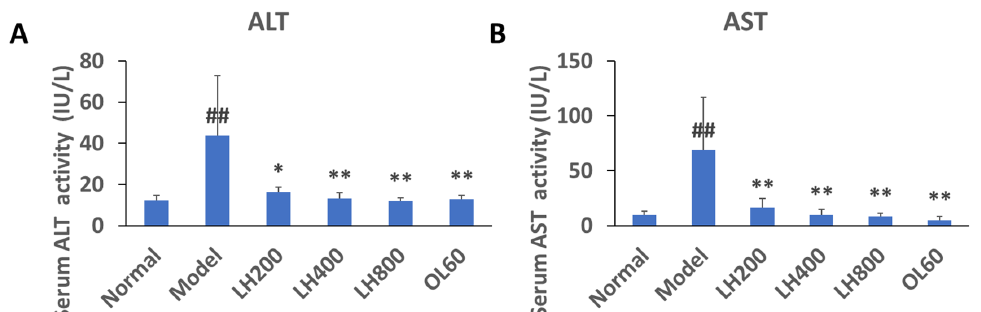
Figure 6. Effects of LH on ( A ) serum alanine aminotransferase (ALT) and ( B ) aspartate aminotransferase (AST) activity in mice. Data are presented as mean ± SD, ## P < 0.01 vs normal group; * P < 0.05 and ** P < 0.01 vs. high-fat control group, n = 10. Normal, normal group; model, high-fat control group. LH200, LH400, and LH800: groups orally treated with LH at dosages of 200, 400, and 800 mg/kg/day, respectively; OL60: group orally treated with OL at 60 mg/kg/day.